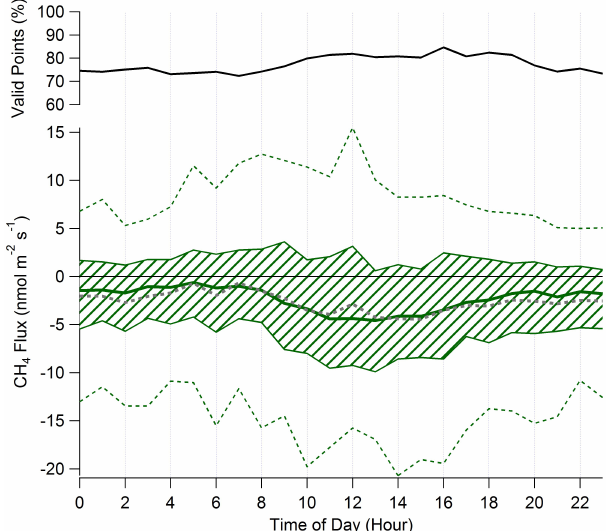
Fig. 4. Median diurnal cycle of percent of valid points within each hour (black) and CH 4 fluxes (bold) and average flux (dashed gray), with interquartile range (shaded area), and the 5th and 95th per- centile range (indicated by dashed line) over the measurement pe- riod.